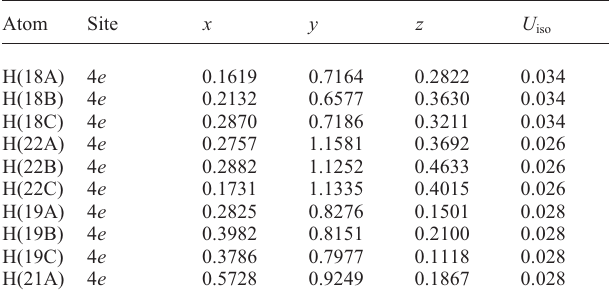
Table 3. Atomic coordinates and displacement parameters (in Å 2 )